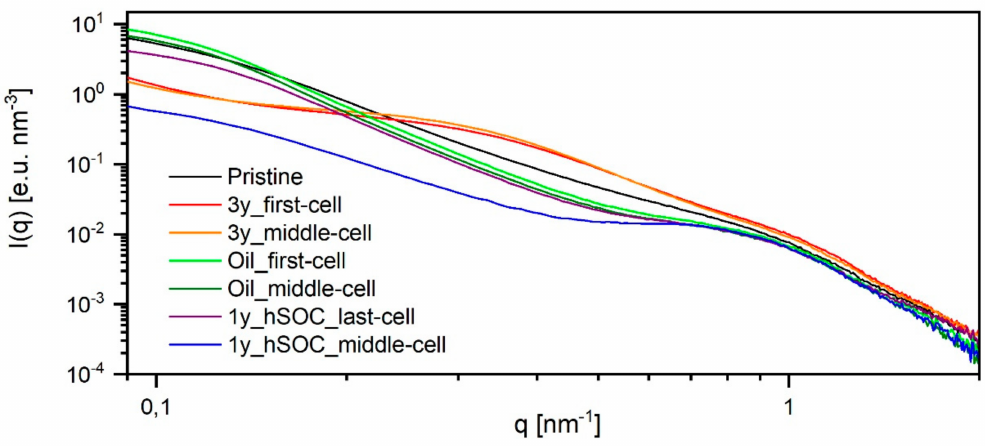
Figure 3. SAXS pattern, scattering data of membranes retrieved from decommissioned stacks and pristine membrane. The data are normalized to primary beam intensity and sample thickness and corrected for background